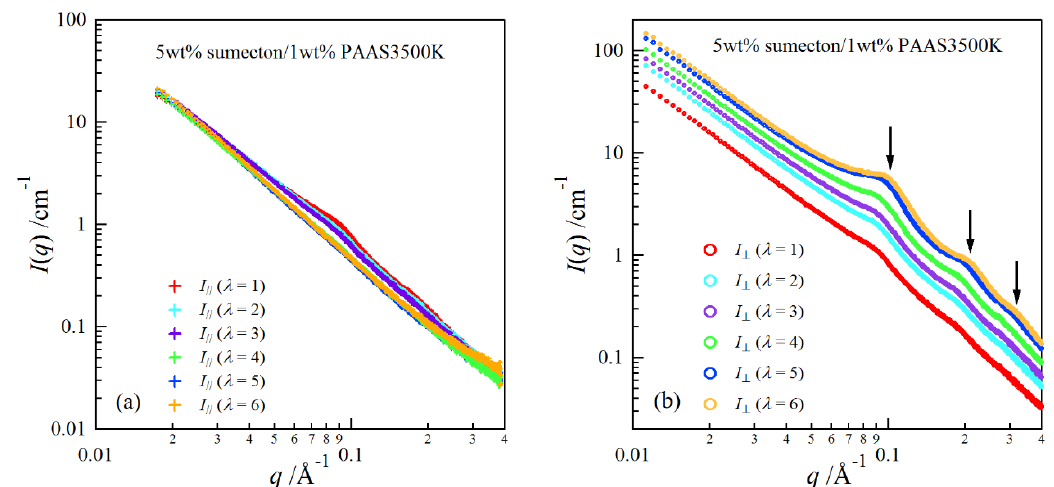
Figure 9. SAXS profiles at different elongation ratios in the parallel direction ( a ) and in the perpendicular direction ( b ) for the sumecton/PAAS gel.